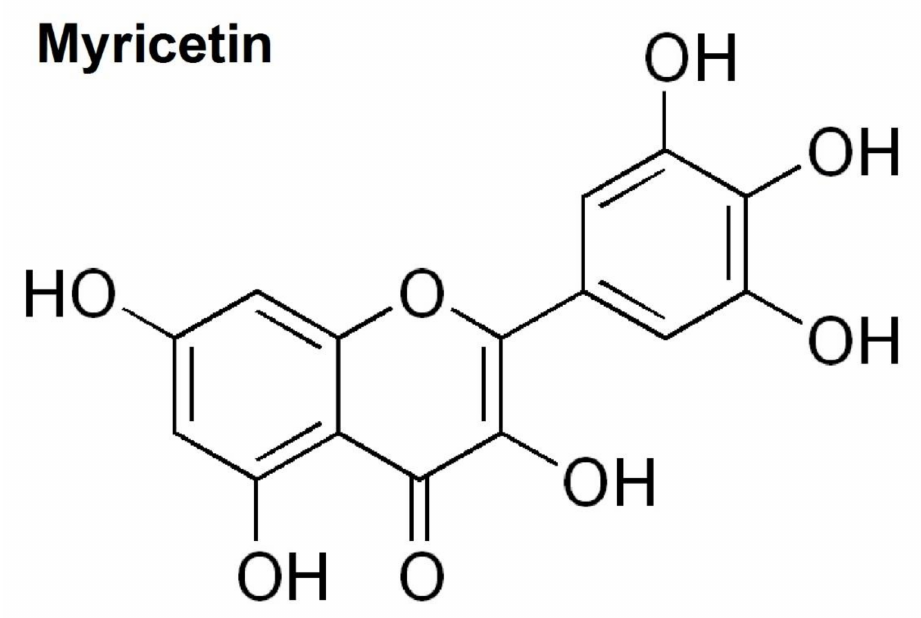
Figure 1. Chemical structure of